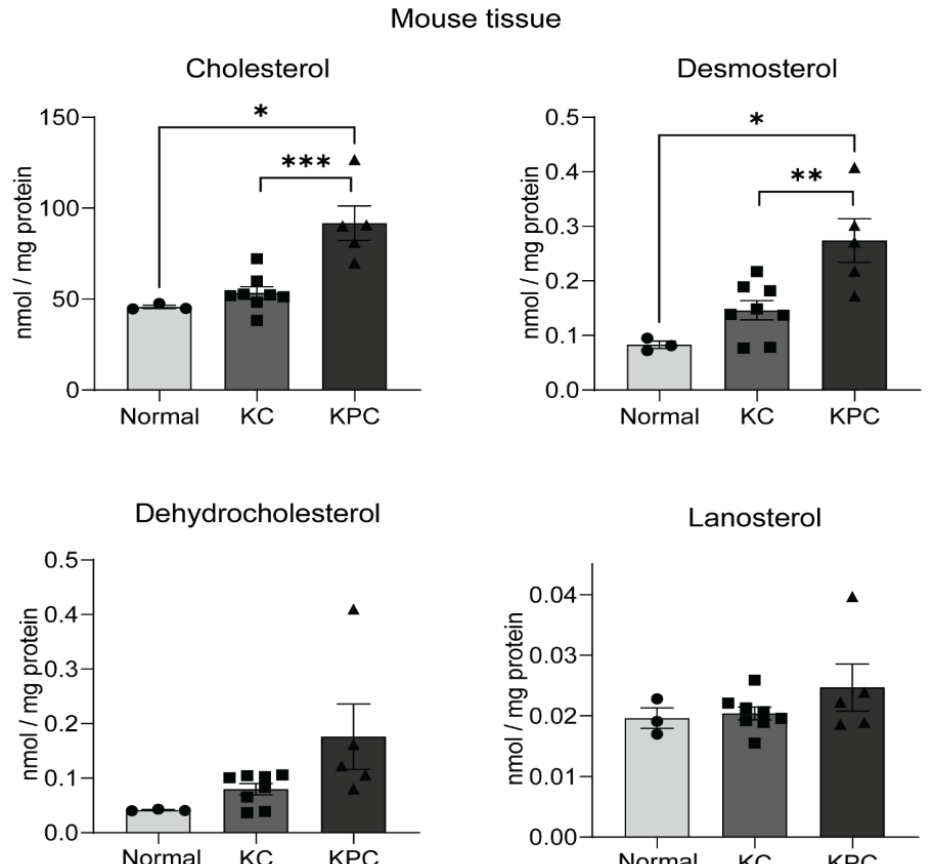
Figure 4. Sterol levels increase in GEMM models of pancreatic cancer: Mean and standard deviation plots showing sterol levels in normal, Kras G12D ; PdxCre (KC) and Kras G12D ; Trp53 R172H ; PdxCre (KPC) pancreatic tissues. *, ** and *** indicate p < 0.05, 0.01 and 0.001 respectively, obtained through un- paired t- test.